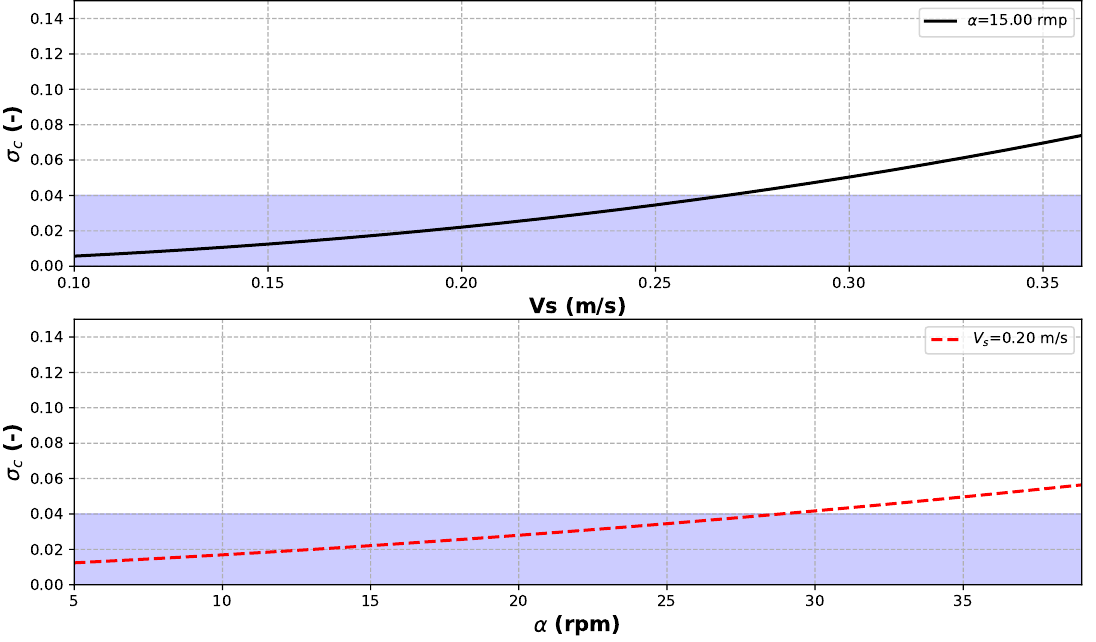
Figure 3. Empirical source term fraction ( σ c ) for cutter-head induced re-suspension as a function of the swing speed ( V s , upper panel) and of the rotational speed of the cutter ( α , lower panel) as estimated on the basis of the model proposed by Hayes et al. [33]. Shaded areas highlight the range suggested by Becker et al.